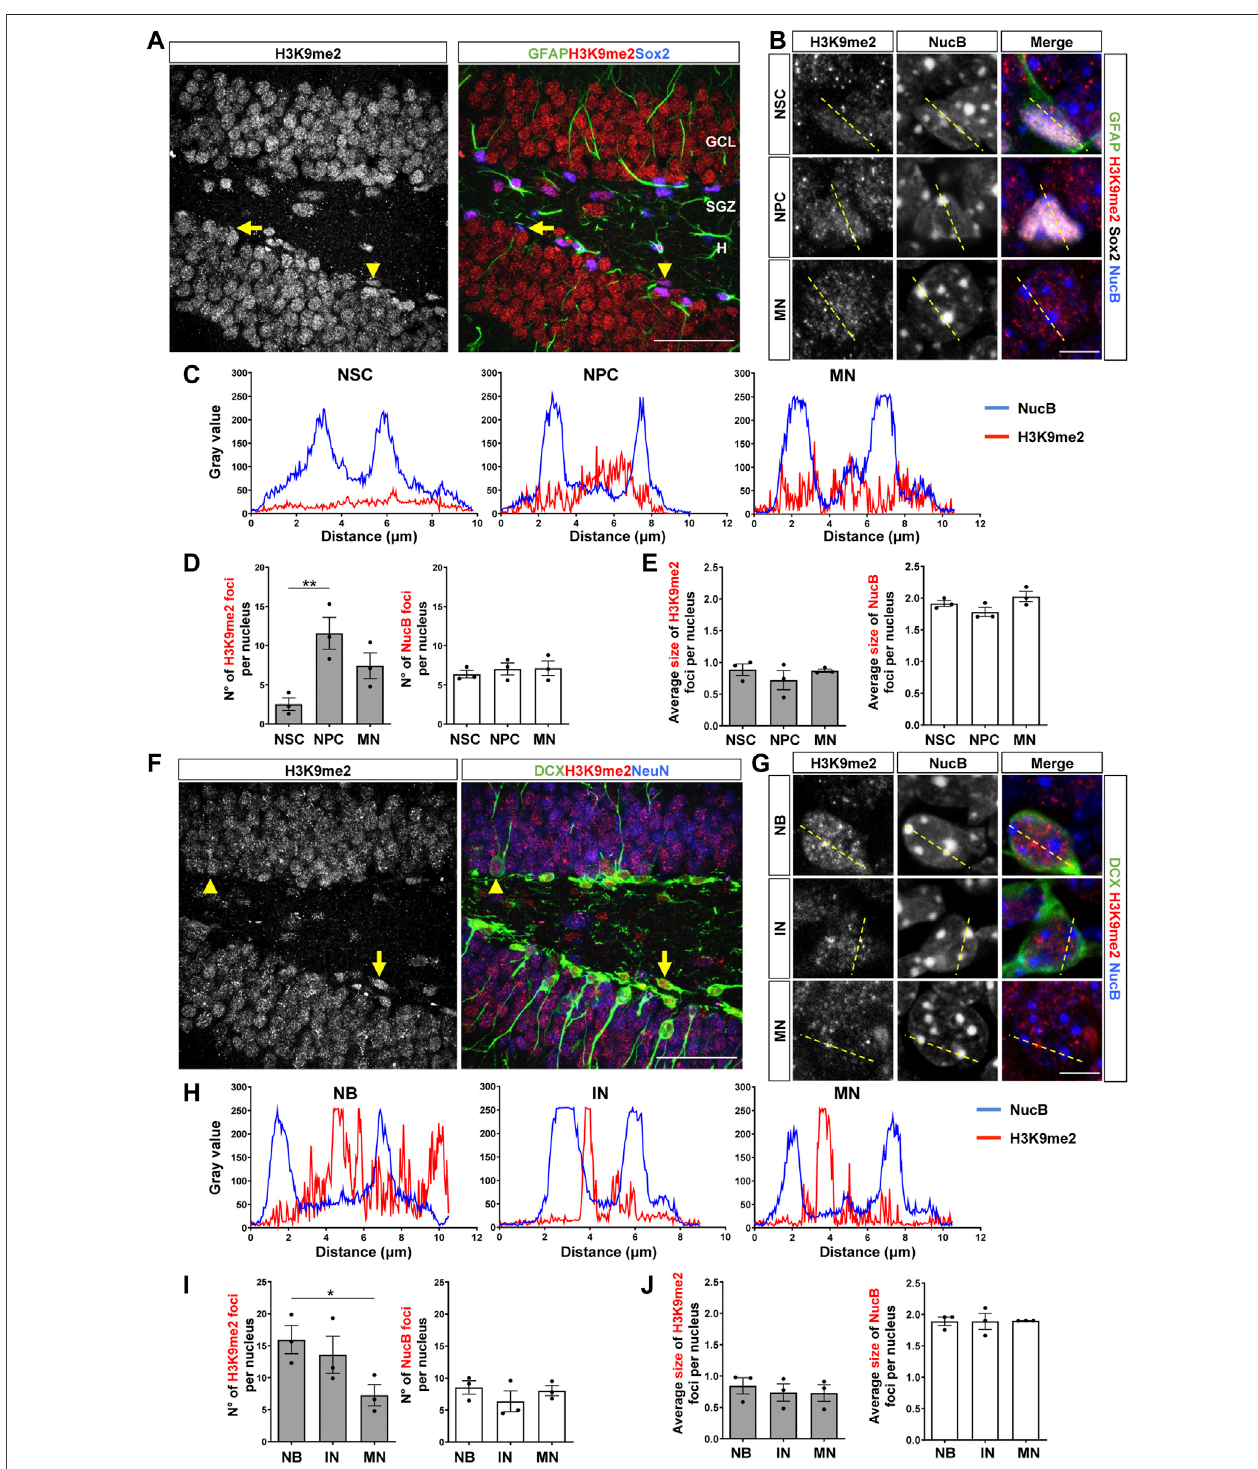
FIGURE 2 | Nuclear H3K9me2 staining and distribution during the stages of neurogenesis in the adult mouse hippocampus. (A) Immunostaining of H3K9me2, GFAP and Sox2 in the DG of 2-month-old mouse. The arrow indicates a NSC (GFAP+Sox2+), the arrowhead indicates a NPC (GFAP-Sox2+). Scale bar 50 µm. Higher magni fi cations are shown in Supplementary Figure S2A . (B) Digital zoom of nuclei from NSC (top), NPC (middle) and mature neuron (MN, bottom). GFAP (green), H3K9me2 (red), Sox2 (white) NucB (blue). Dotted lines indicate the line scans analyzed in C. Scale bar 10 µm. (C) Fluorescence intensity of H3K9me2 (red) and NucB(blue)inlinescansdrawnacrosschromocentersinnucleifromNSC,NPCandMNusingasingleconfocalsection. (D) AveragenumberofH3K9me2andNucBfoci